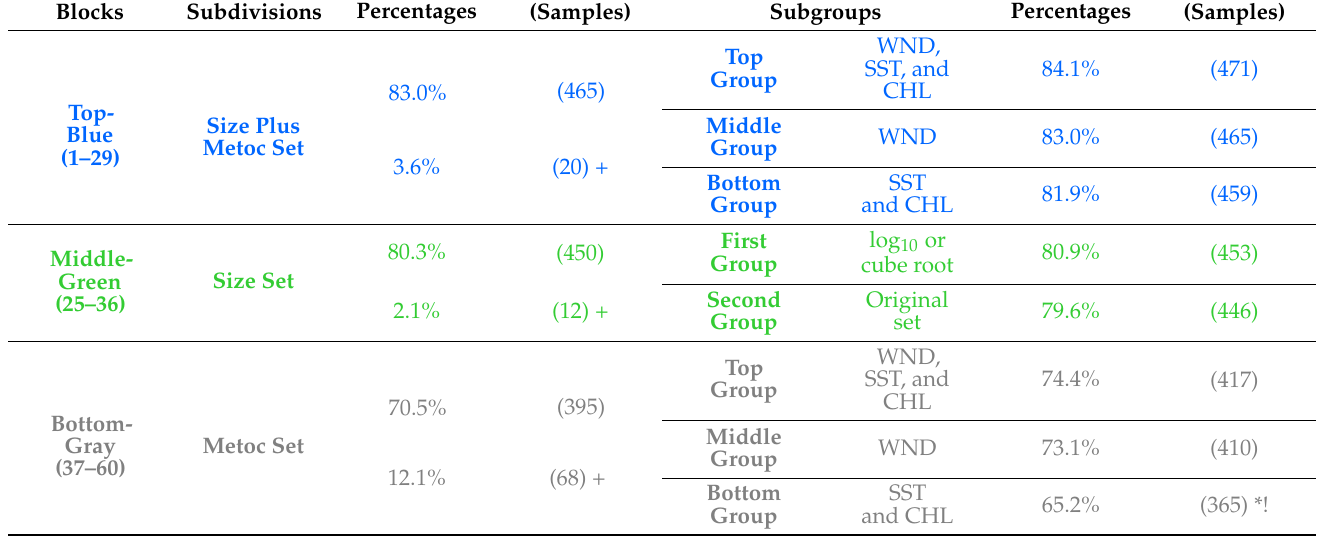
Table 4. Averaged overall accuracies of Experiment 1 (Data Information). Three hierarchy blocks and their respective subgroups (as color-coded in Table 3A,B): size information plus Meteorological-Oceanographic (metoc) variables (blue: 1–29), “Size Set” (green: 25–36), and “Metoc Set” (gray: 37–60), all of which were analyzed with or without at least one geo-location (geo-loc) parameter and were subjected to the same data transformations. Averaged number of correctly classified samples is provided in parentheses. Blocks match the proposed attribute-type subdivisions (Figure 3). + indicates the range of accuracies (and samples) in these blocks. * indicates unbalanced identification rate: algorithms correctly identifying 30% or more oil spills than look-alike slicks. ! indicates void algorithms: at least one performance metric below 60%, i.e., specificity. See also Section